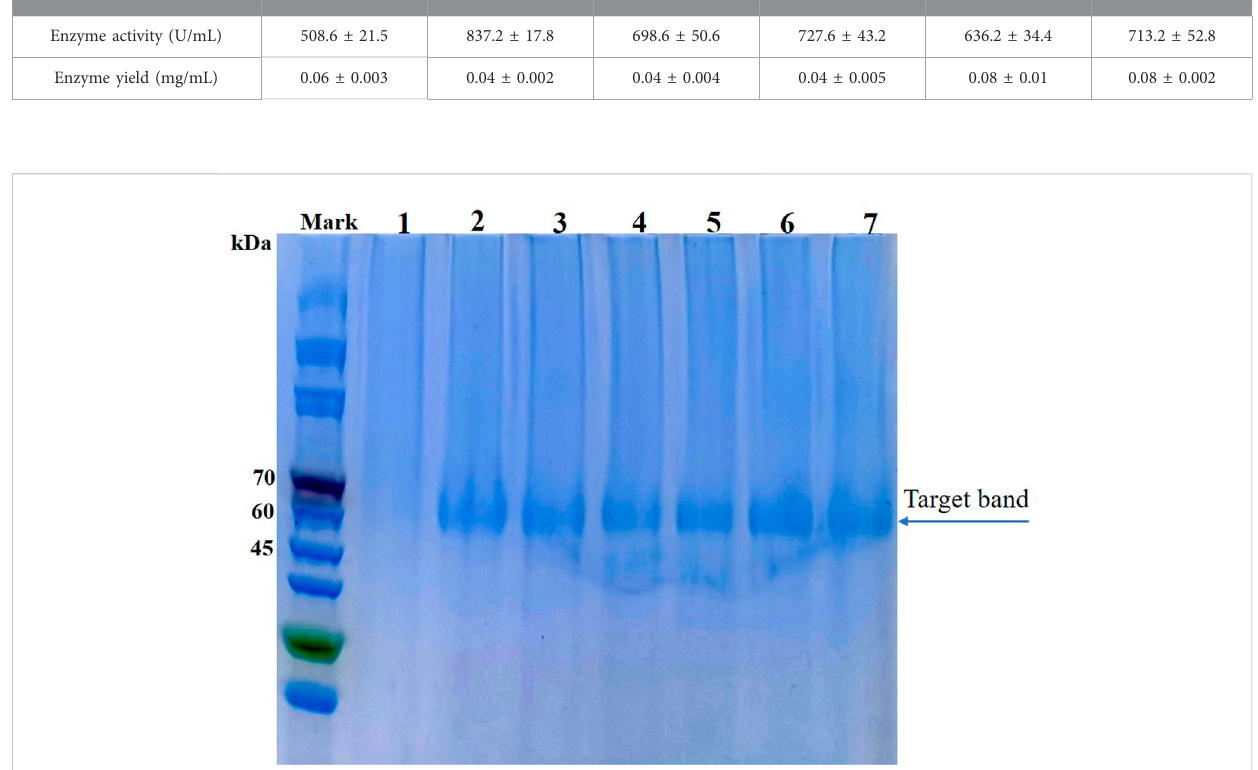
Sodium dodecyl sulfate – polyacrylamide gel electrophoresis analysis of parent and thermostable variants expressed in P. pastoris (analysis was performed using culture supernatant). Lane 1: Empty vector; Lane 2: Parental phytase A1; Lane 3: D7; Lane 4: E3; Lane 5: F8; Lane 6: F9; Lane 7: G10.